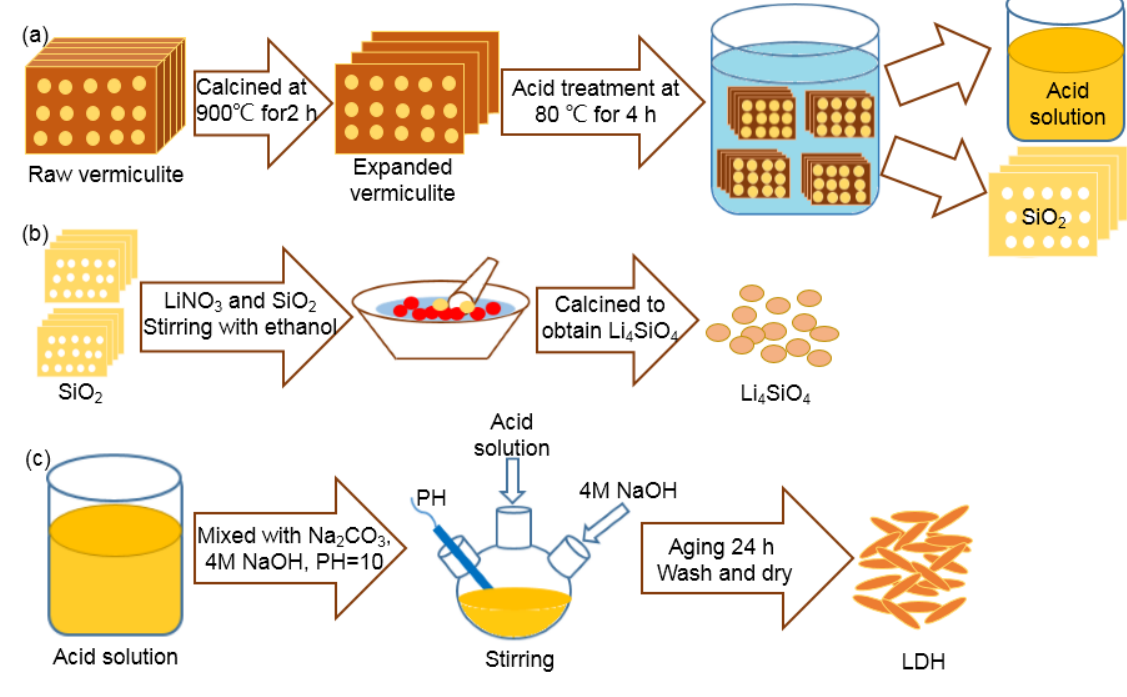
Figure 1. Schematic illustration of the synthesis of Li 4 SiO 4 and LDH from vermiculite, ( a ) the vermiculite is treated with acid to obtain a silica and an acidic solution, ( b ) the synthesis of Li 4 SiO 4 from the SiO 2 obtained in step ( a ), and ( c ) the synthesis of LDH from the acidic solution obtained in step ( a ).